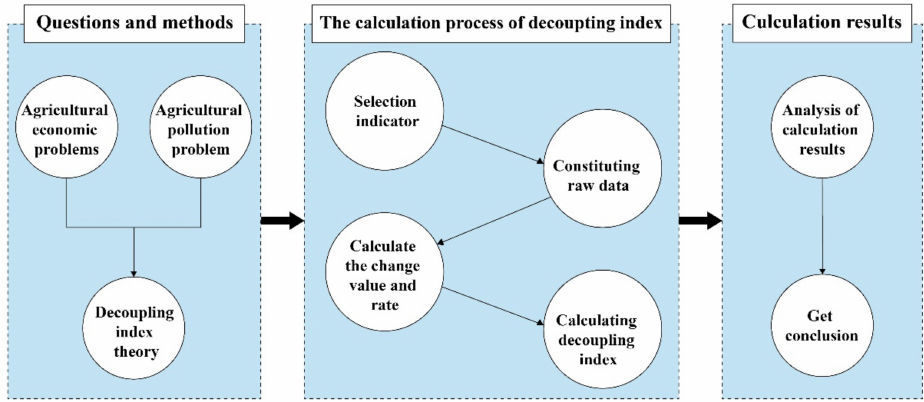
Figure 1. Research framework for decoupling analysis of agricultural economy and agricultural